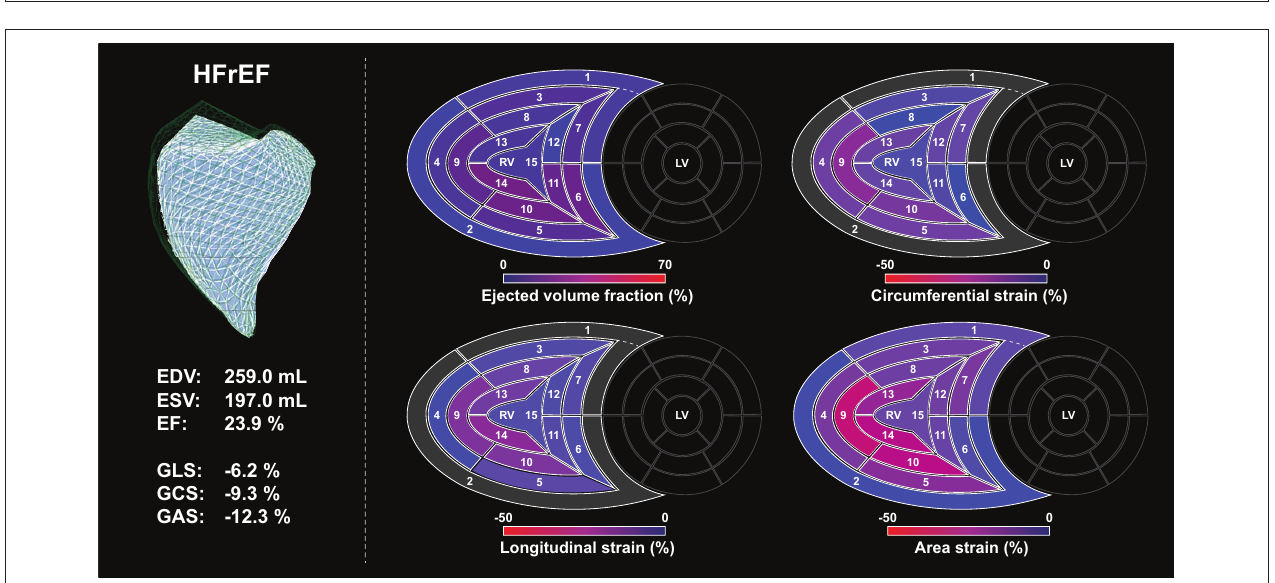
FIGURE 11 | A healthy, sedentary subject’s (male, 23 years old) right ventricle analyzed using the ReVISION method. Right ventricular end-diastolic volume, end-systolic volume, and ejection fraction are normal, along with global longitudinal, circumferential, and area strains. Segmental values of the aforementioned metrics at end-systole are depicted on bull’s eye heatmaps. Segment numbers as defined in Figure 3 . In the upper left corner, the green mesh represents the end-diastolic volume, and the blue surface corresponds to the end-systolic volume. EDV, end-diastolic volume; EF, ejection fraction; ESV, end-systolic volume; GAS, global area strain; GCS, global circumferential strain; GLS, global longitudinal strain; LV, left ventricle; RV, right ventricle.